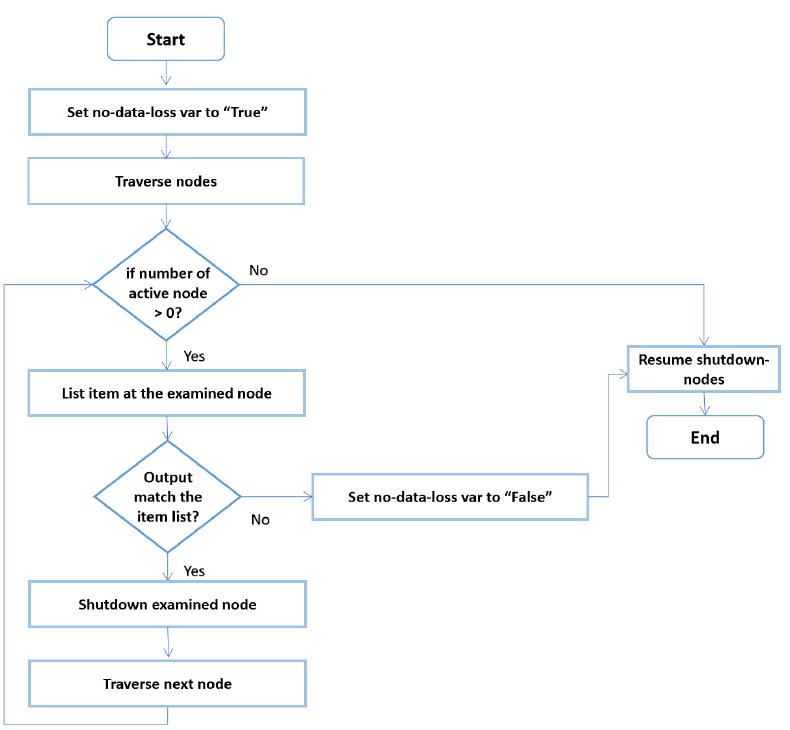
Figure 6. Flow diagram of data veracity with data loss tolerance verification.